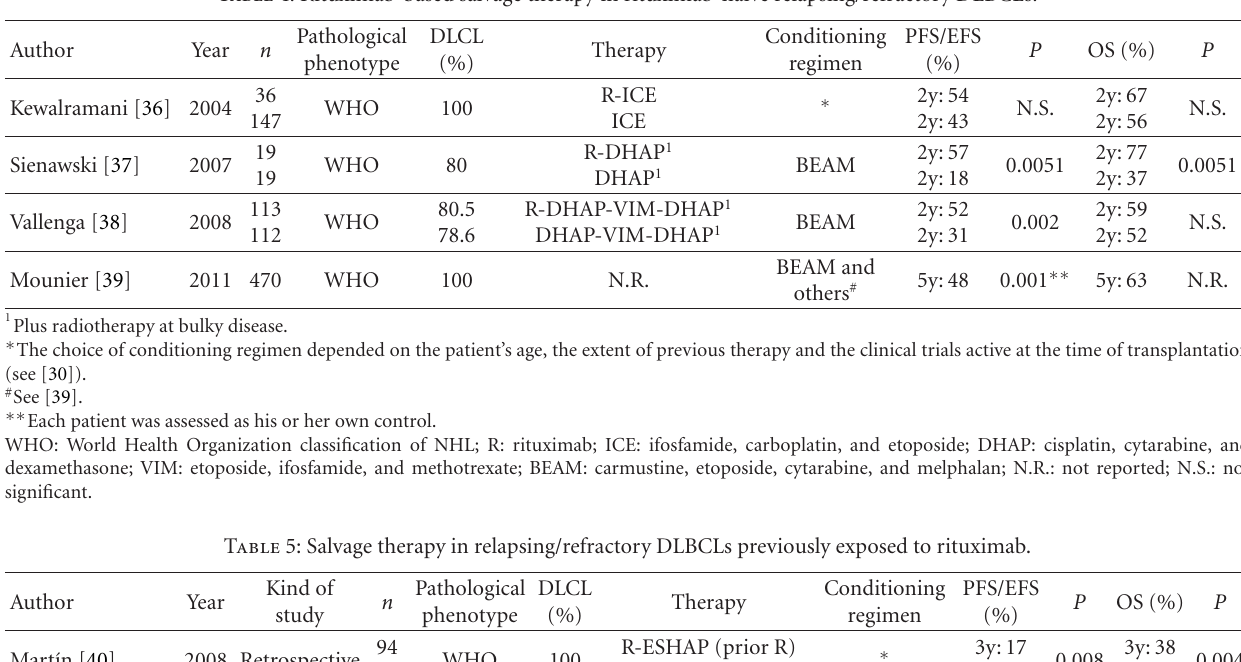
Table 4: Rituximab-based salvage therapy in rituximab-na¨ıve relapsing/refractory DLBCLs.